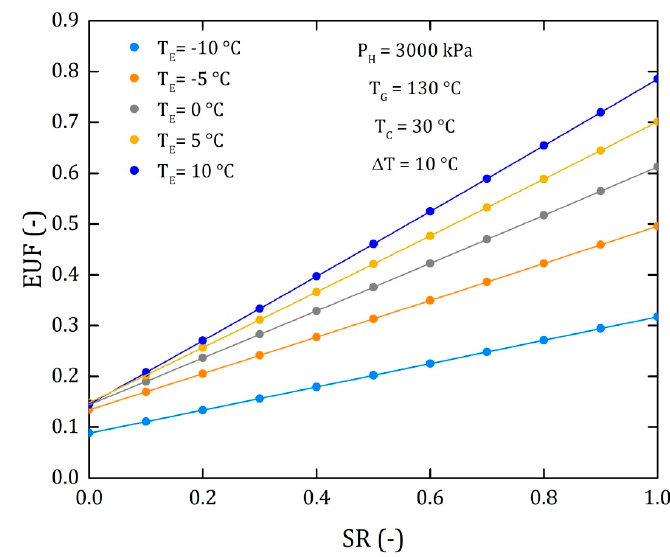
Figure 6. Energy utilization factor (EUF) as a function of split ratio (SR) for Model II for different evaporator temperatures.